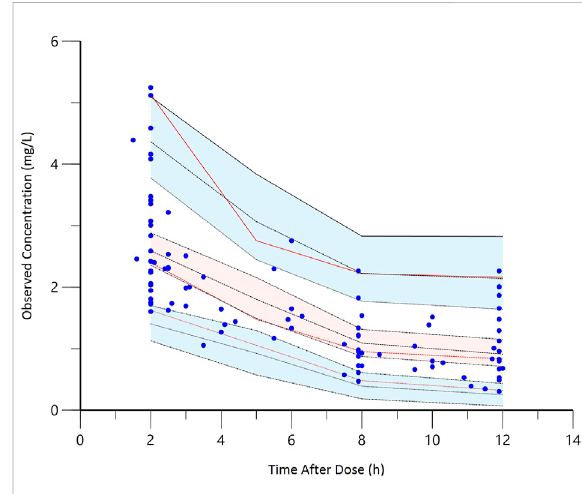
FIGURE 2 The prediction-corrected visual predictive check (pcVPC) of the fi nal model. The red lines represent the 5th, 50th, and 95th percentiles of the observed concentrations; the shaded areas represent the 80% con fi dence intervals of the 5th, 50th, and 95th percentiles of the simulated concentrations; the dots represent the observed data.